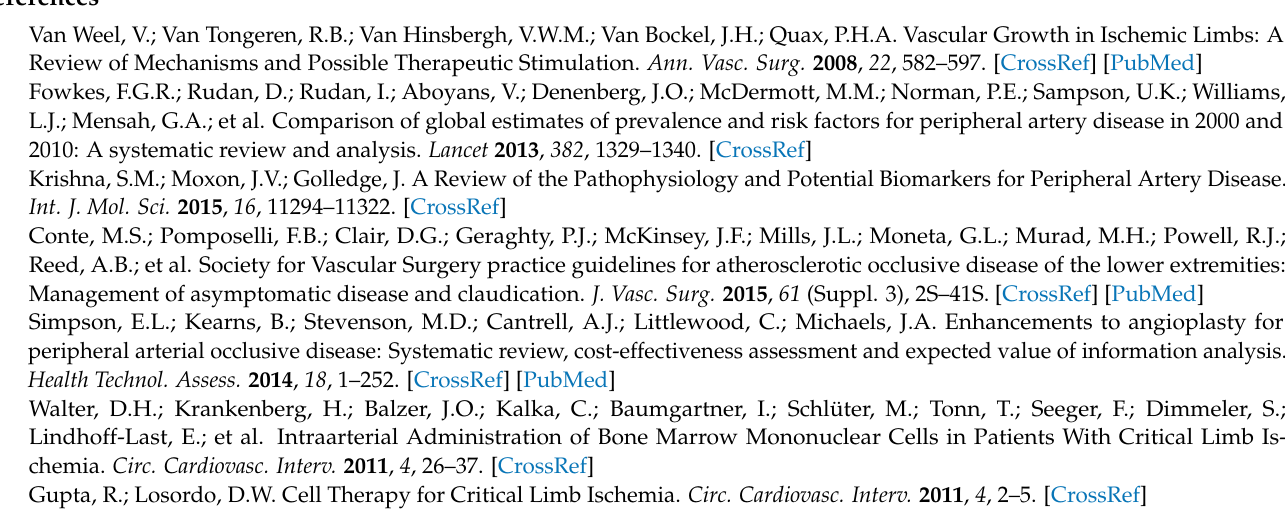
density; Figure S3: Volcano plot, Figure S4: Cytokine expression arrays, Supplementary Materials and Methods, Table S1: Functional scoring related to ischemia, Table S2: Quantitative analysis of proteins differentially expressed (vs. SH), Table S3: Functional classification of proteins differentially expressed due to administration of AP-prestimulated CACs, Table S4: Proteins differentially expressed in SF vs. SE related to